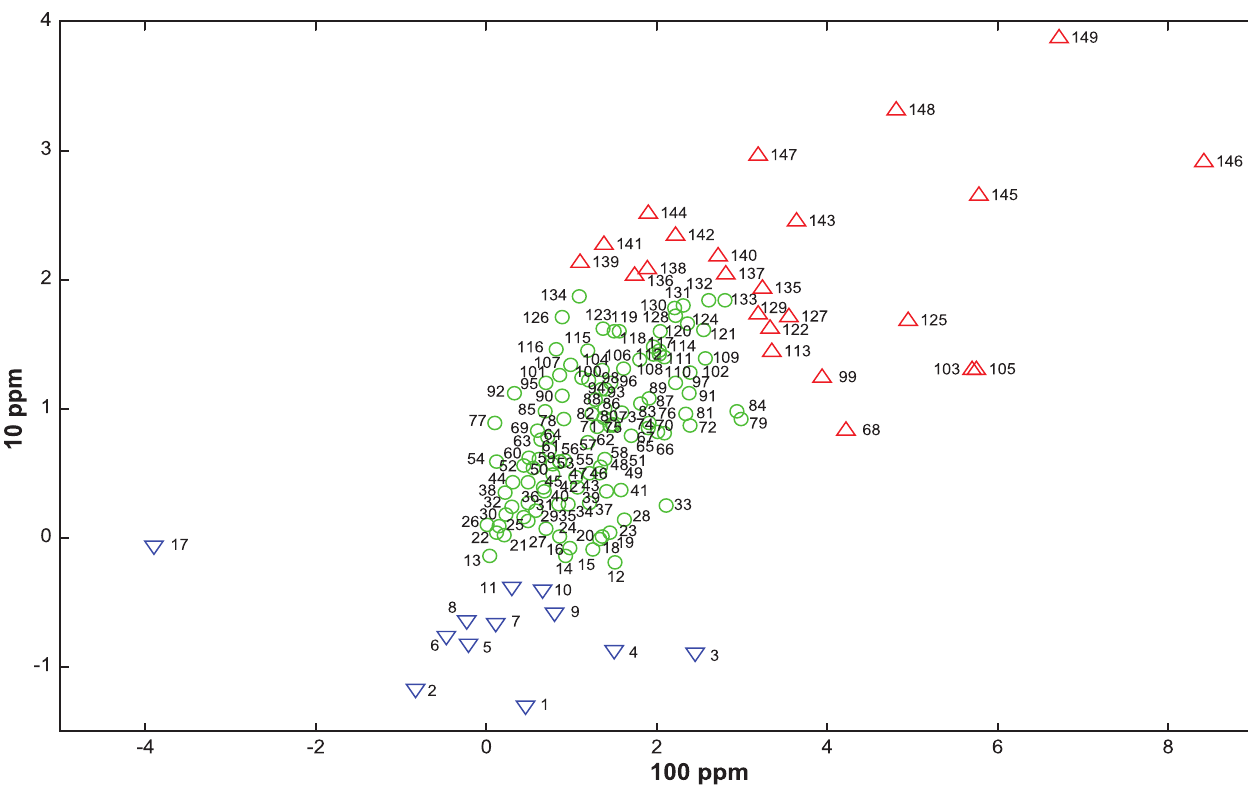
Fig 5. Averaged integrated score of proteins extractedfrom total lysis of E . coli culture in contact with 10 ppm nano-TiO 2 as a function of the averagedintegrated score when cells are in contact with 100 ppm nano-TiO 2 . The averagefigures are computedbased on all four nano-TiO 2 treatments. Proteins in red trianglespointing upwardsare considered as up-regulated, while those in blue trianglespointingdownwards are considered as down-regulated.